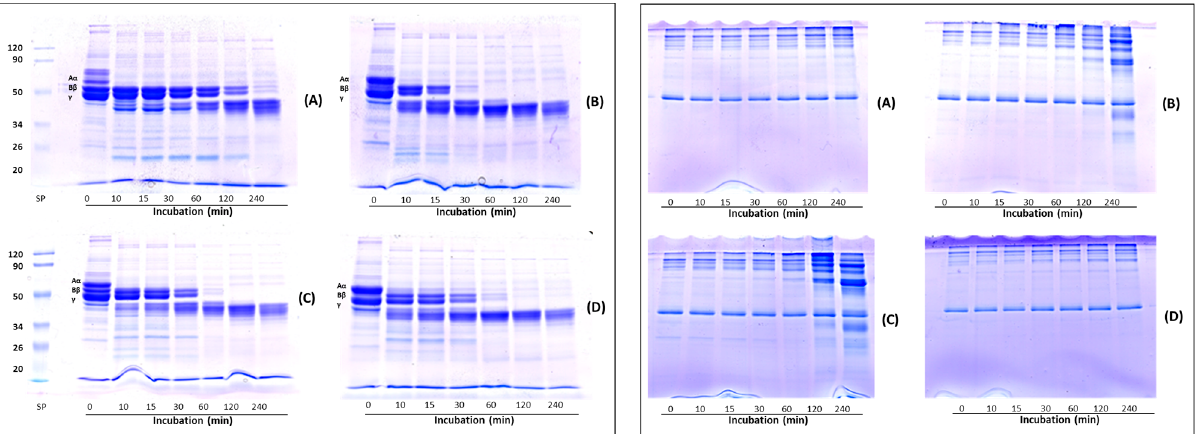
Figure 4. Analysis of fibrin(ogen)olysis patterns by SDS-PAGE. Fibrinogenolysis ( left panel ) and fibrinolysis ( right panel ) patterns exhibited by crude extracts from Lentinula edodes ( A ), Pleurotus ostreatus ( B ), Pleurotus eryngii ( C ) and Agrocybe aegerita ( D ). Crude extracts were incubated with 0.4% human fibrinogen or 0.2% human fibrin in 20 mM Tris-HCl, pH 6.8 at 37 °C, then aliquots of the reaction mixture were removed at different time intervals and analyzed by SDS-PAGE.